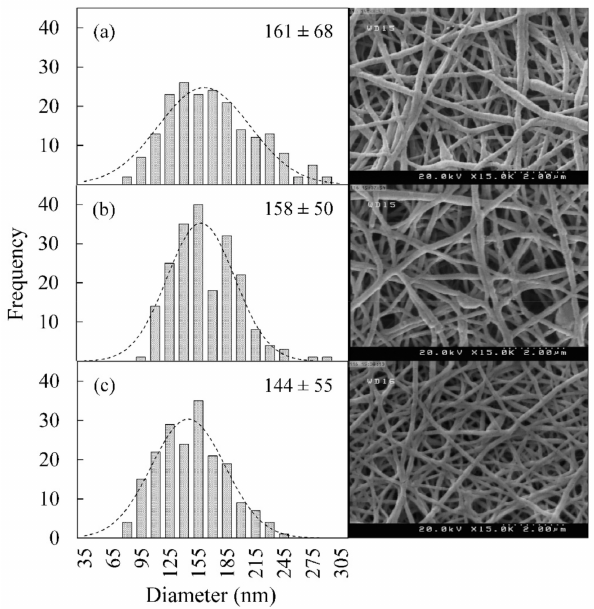
Figure 2. SEM images ( right ) and fiber diameter distribution ( left ) of the nanofiber samples (PCL/Gel) with different EPS contents: ( a ) 0% EPS ( b ) 1% EPS ( c ) 2%